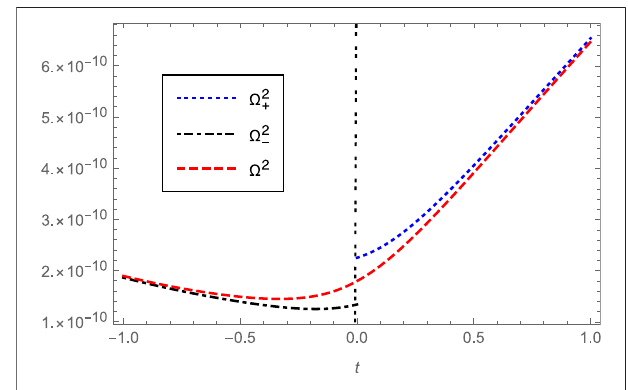
FIGURE 3 | The potential terms Ω 2 + and Ω 2 − are compared with their smoothextension Ω 2 acrossthebounce inmLQC-I